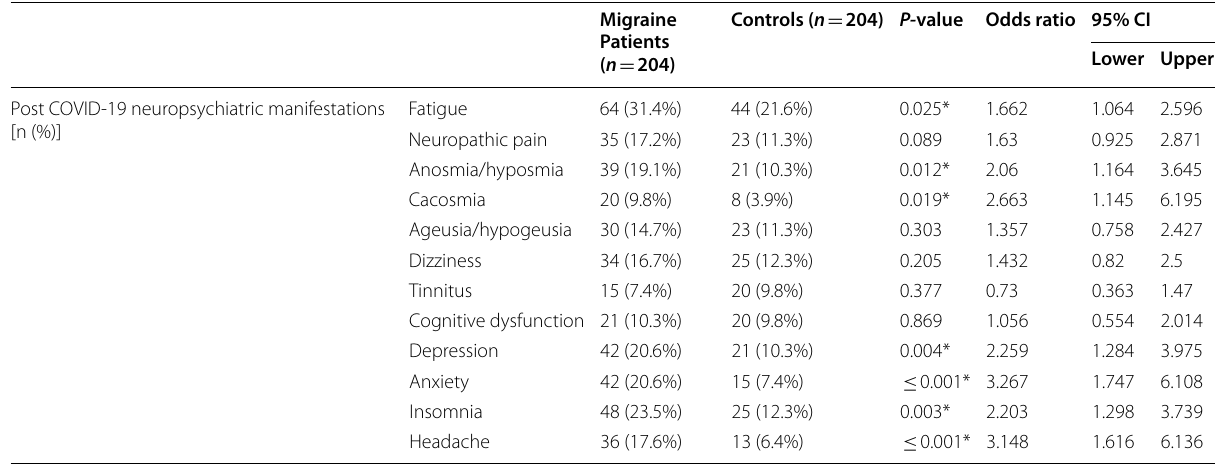
P- value 0.05 is considered significant ≤ The P values were adjusted for multiple testing using Benjamini and Hochberg